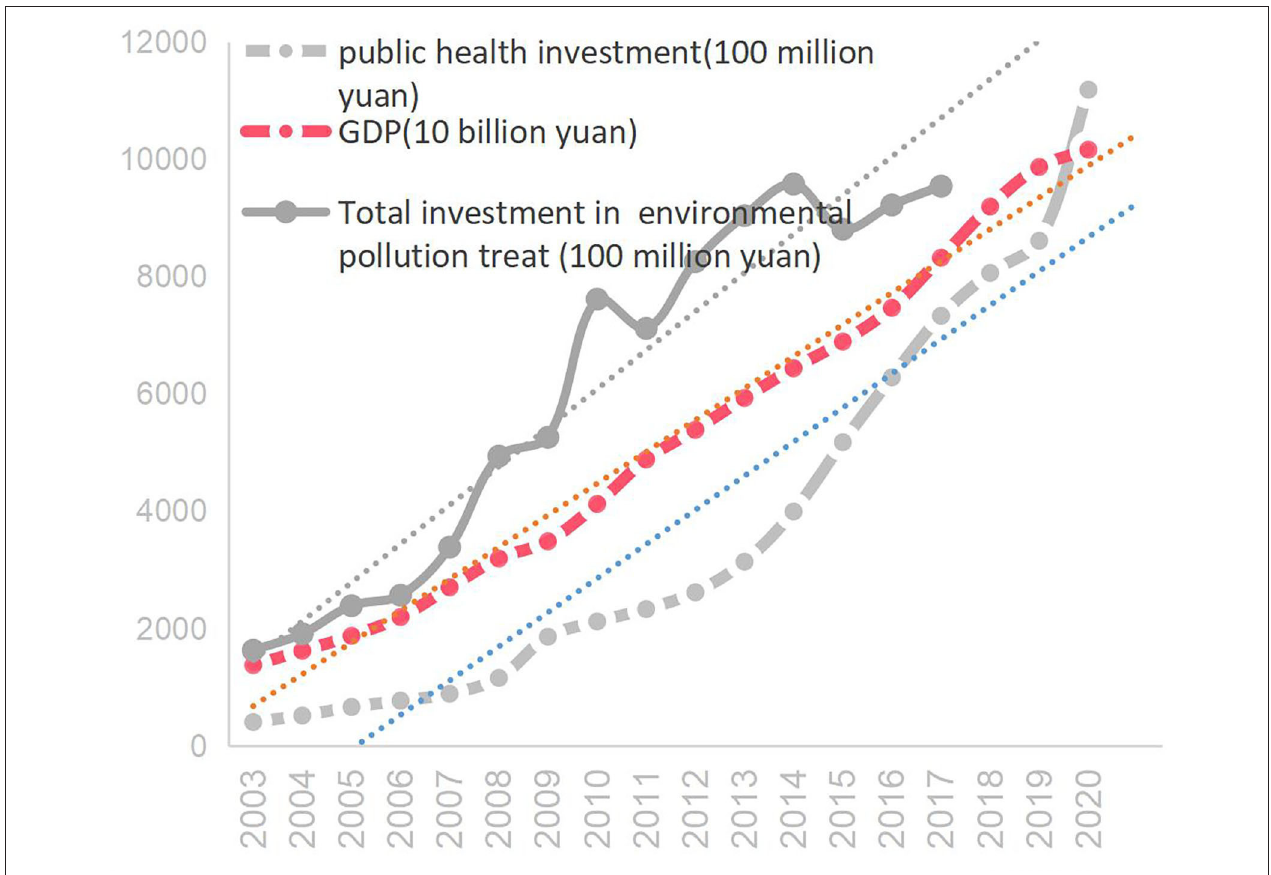
FIGURE 1 | China’s public health investment, treat environmental pollution investment and GDP. Source: National data from the National Bureau of Statistics of China 3